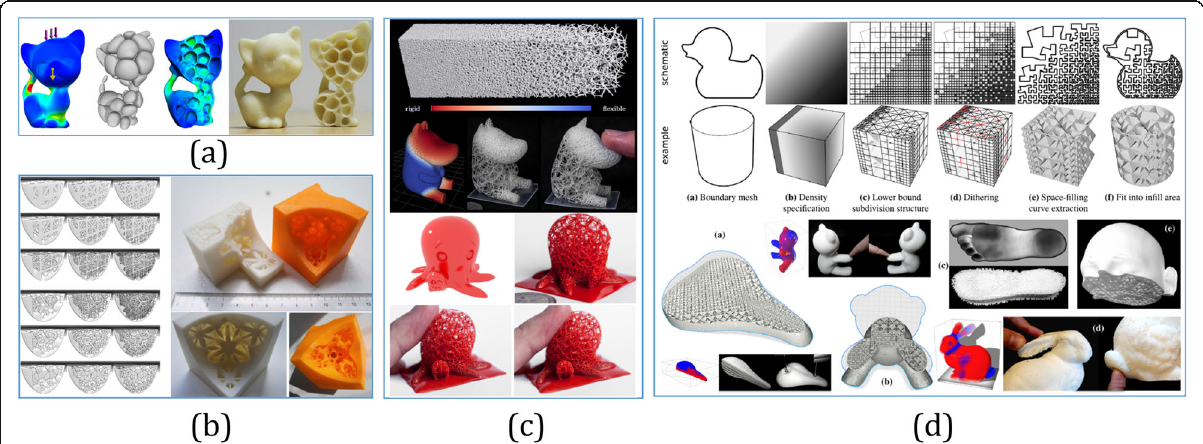
Fig. 9 a Voronoi-diagram-based honeycomb-cell structure [82]. b Parameterized adaptive infill primal and/or dual cellular structure to hollow the solid models [83]. c Voronoi-based foam structure with controlled isotropic elastic behavior [84]. d Self-supporting foam structure based on a space-filling surface with spatially varying subdivision levels